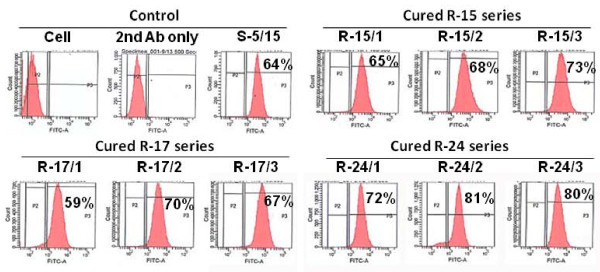
Flow cytometry of IFNAR1 expression in IFN-α resistant Huh-7 cells. Flow cytomeric analysis demonstrating expression of full-length mature IFNAR1 between the sensitive Huh-7 line (S-5/15) and nine different alpha resistant Huh-7 cell lines using a rabbit monoclonal antibody targeting to the C-terminus of human IFNAR1 at a dilution of 1:50. The secondary antibody used is anti rabbit IgG Alexa Fluor 488 at a dilution of 1:1000 (Invitrogen, Oregon, USA). The % of positive cells was shown for each cell line.